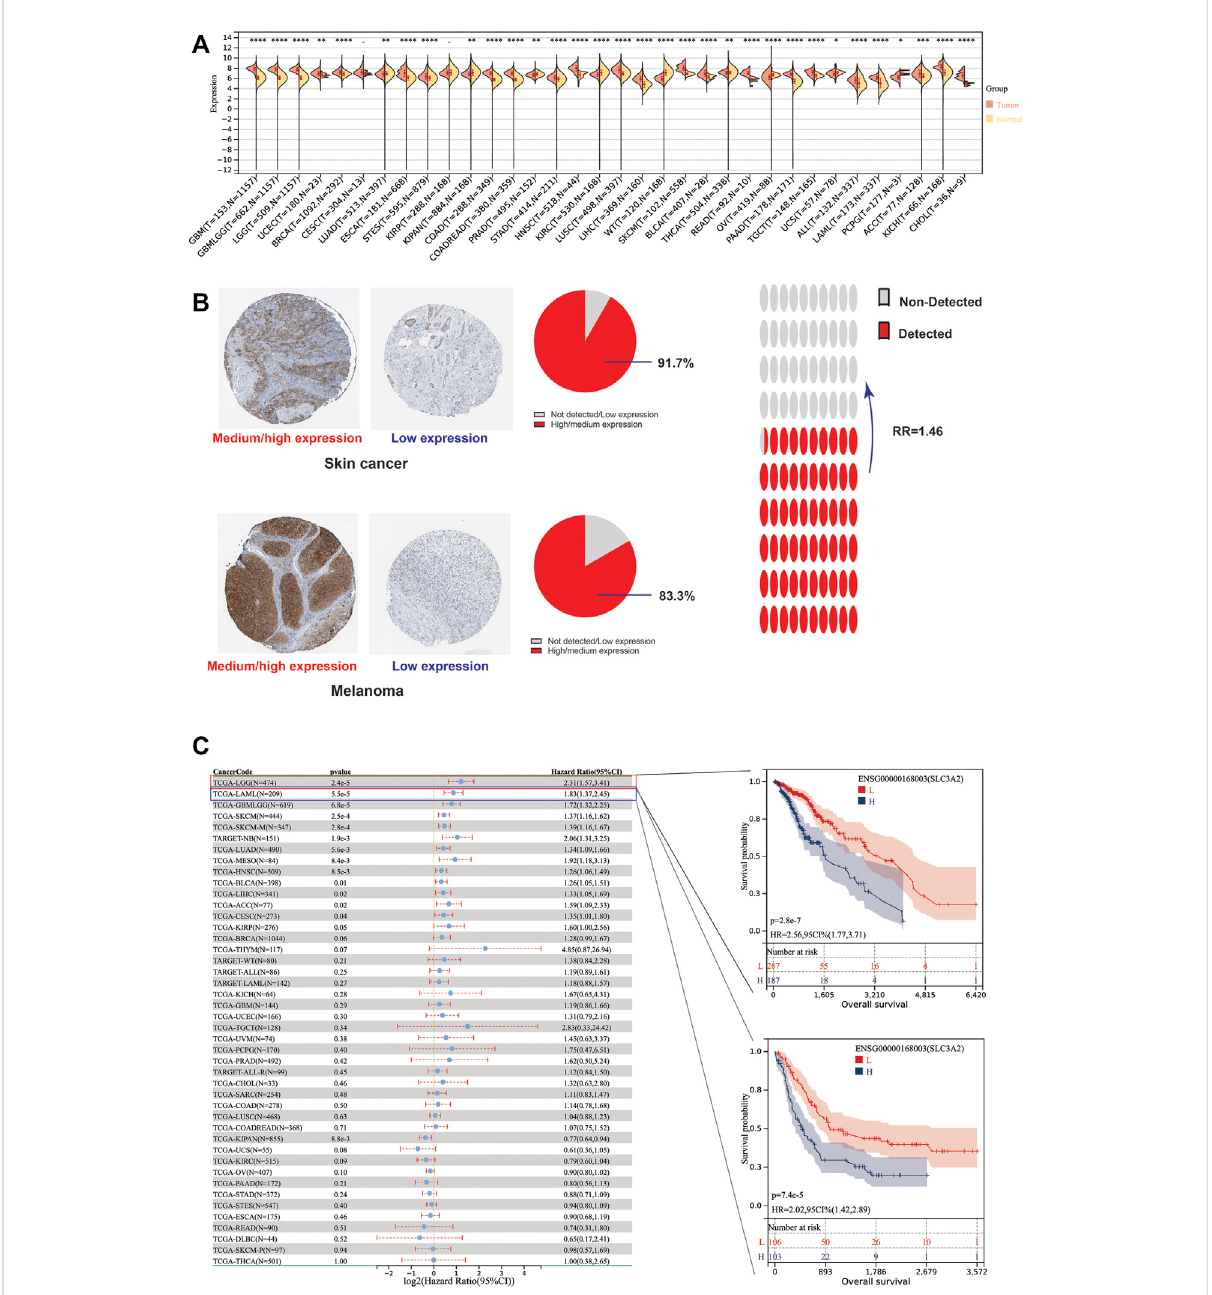
FIGURE 1 Differential expression level and prognostic implications of SLC3A2 among 34 cancers. (A) Differential expression of SLC3A2 between tumor andnormaltissue. (B) ImmunohistochemicalstainingshowedhigherSLC3A2expressionincancers. (C) CorrelationbetweenSLC3A2expressionand OS of patients with